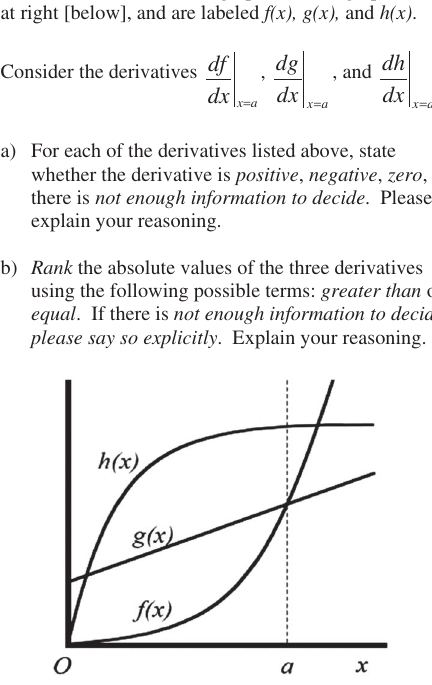
FIG. 3. Original Derivative Sign and Ranking Task. [Later versions featured a curve with a more clearly positive slope for h ð x Þ at x ¼ a ; see Fig. 5.]